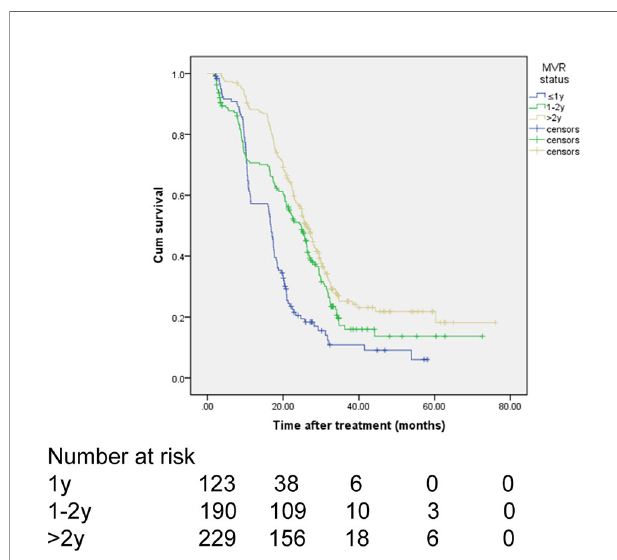
FIGURE 4 | Subgroup analysis of OS in patients with MVR strati fi ed by durations of MVR status.